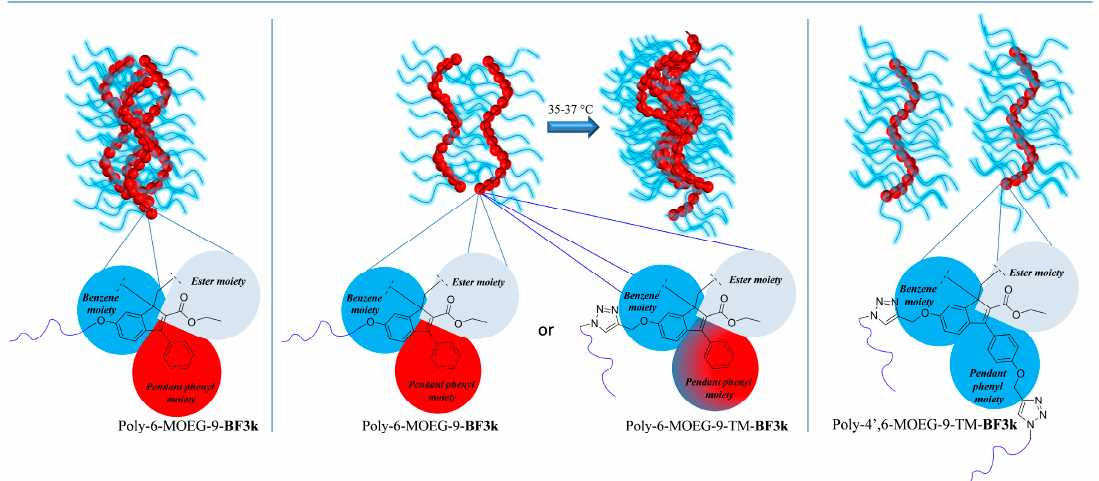
Figure 19. Possible aggregation mechanism in PPBFB derivatives.